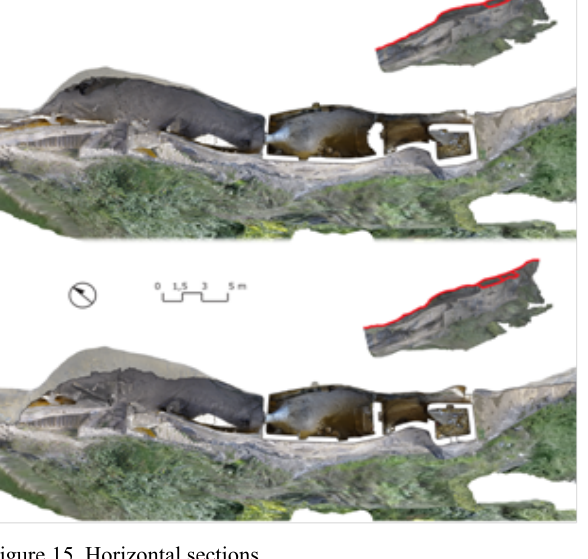
Figure 15. Horizontal sections Figure 16. Vertical